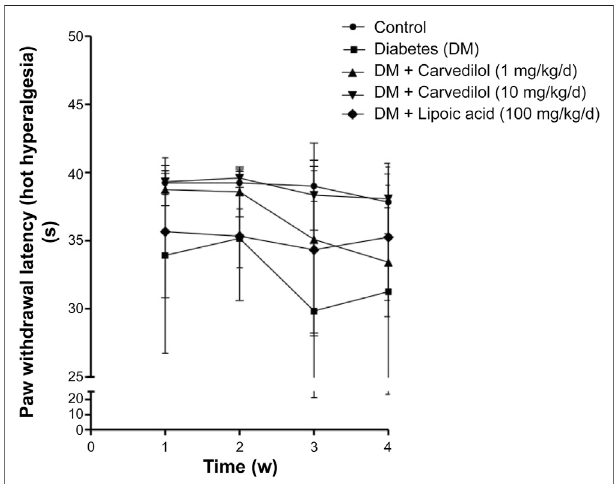
FIGURE 3 | The paw withdrawal latency to hot stimuli in STZ-induced diabetesinrats. Dataare presented asmean ± SD foreach group ( n (cid:2) 6). DM, diabetes mellitus; SD, standard deviation; STZ, streptozotocin; Time (w), time in weeks. Statistical analysis was done by two-way ANOVA.